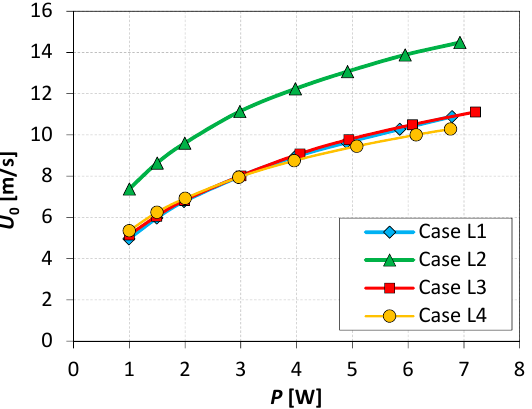
Figure 8. SJ centerline momentum velocities at individual resonance frequency in function of apparent power.